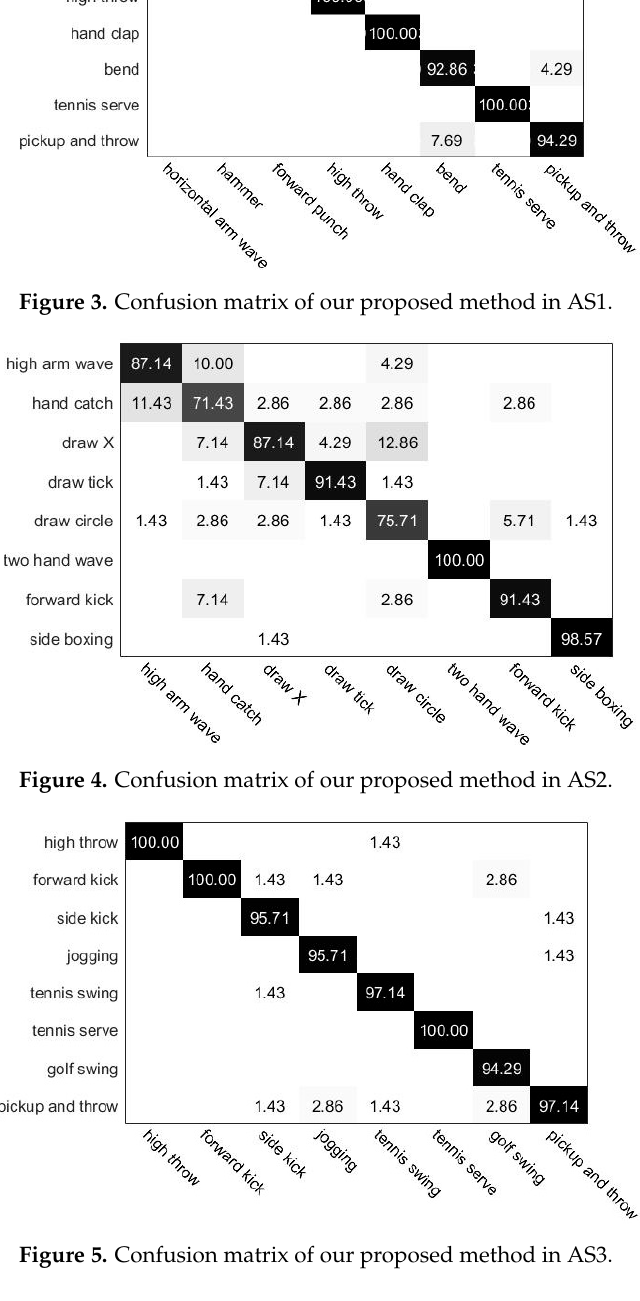
Table 3. Comparisons of the average classification accuracy on MSR-Action3D dataset.